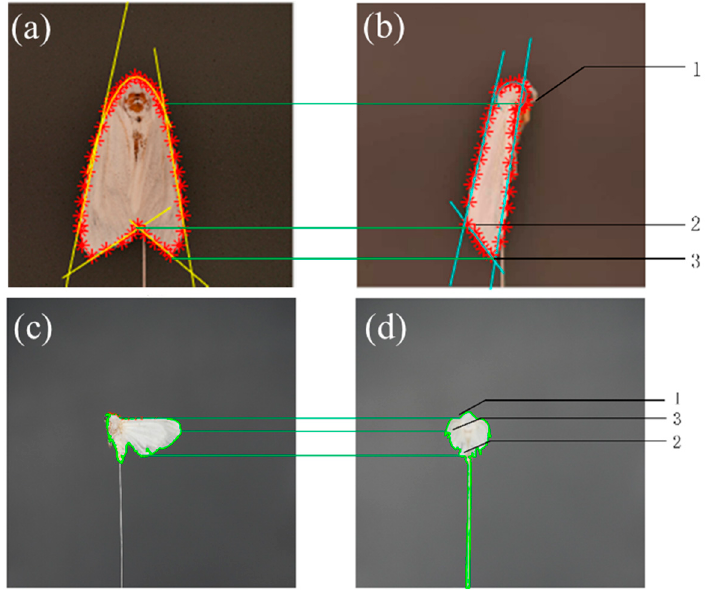
Figure 13. ( a , b ) and ( c , d ) are matching results of key points when the wings angle is less than and greater than 180°, respectively. 1. Point of humeral angle. 2. Point of anal angle. 3. Point of apical angle. Red points are key points, the line in green are edges of the wing.